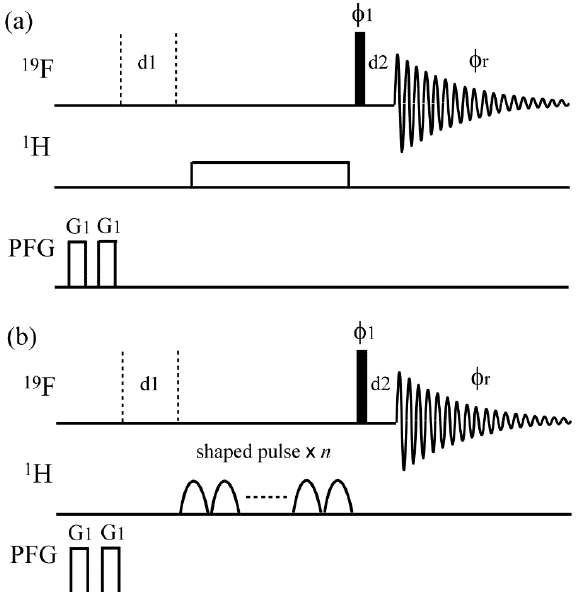
Figure 2. The pulse sequences of the 1 H- 19 F saturation transfer difference (STD) experiment. The thin bars represent 90-degree pulses. All pulses were along the x direction unless otherwise shown. In ( a ), the 1 H pulse width ( H 1 /2) was 1.5 s (40 Hz). In ( b ), I-BURP-1, I-BURP-2 [13], Q 3 [14], G3 [15], and Gaussian [16] shaped pulses were used for evaluations. Each pulse width ( H 1 /2) was 4.67 ms (715 Hz), 4.87 ms (1133 Hz), 3.77 ms (900 Hz), 3.86 ms (637 Hz), and 0.866 ms (1426 Hz), respectively. The repetitive time n was adjusted for the total saturation time. The experimental parameters were; d 1 = 1.0 s, d 2 = 10 μs, G 1 = 7.2 G/cm, gradient pulse width = 2.0 ms. Phase cycling: φ 1 = x , − x , − x , x , y , − y , − y , y ; φ r = x, x, −x, −x, y, y, −y, −y . In the 19 F- 1 H STD experiment, two channels of 19 F and 1 H were switched.